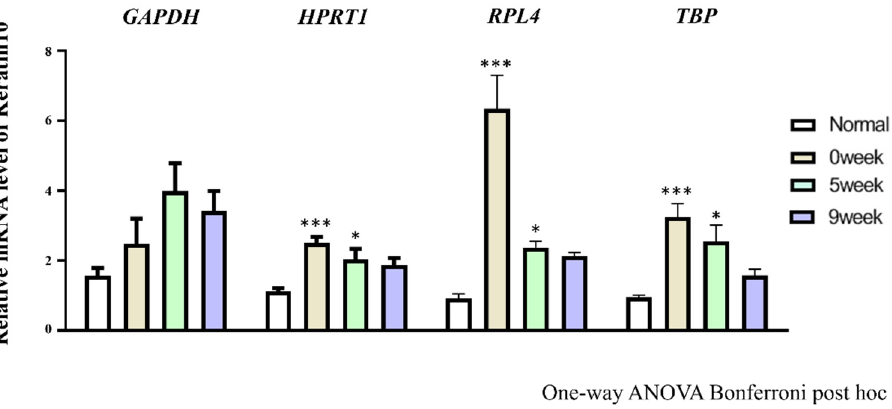
Figure 5. The application to normalization of estimated reference gene. The normalization used stable ( HPRT1, RPL4 and TBP ) or the least stable ( GAPDH ) reference gene. Keratin 10 gene was normalized by HPRT1, RPL4, TBP and GAPDH to prove the influence of reference gene stability. Significant (* p < 0.05; *** p < 0.0001) differences in Keratin 10 expression level between normal and post irradiation skin are presented as an asterisk. Table 3. Rank of reference gene stability all algorithms.